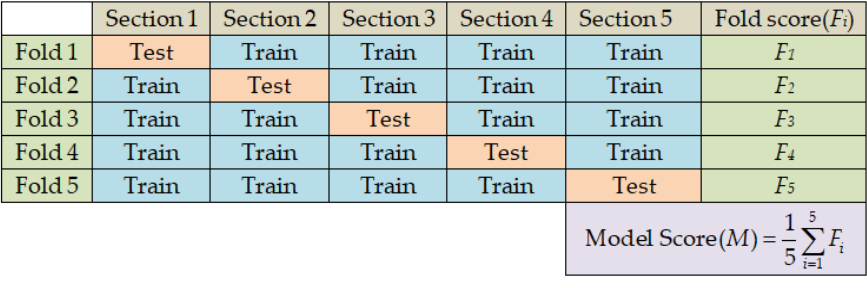
Figure 11. Data splitting and performance evaluation processes in five ‐ fold cross ‐